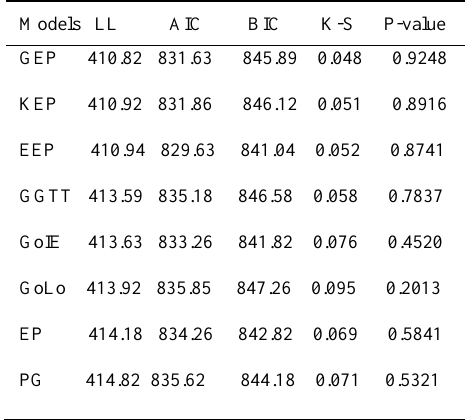
Table 2. Goodness-of-fit estimates for bladder cancer